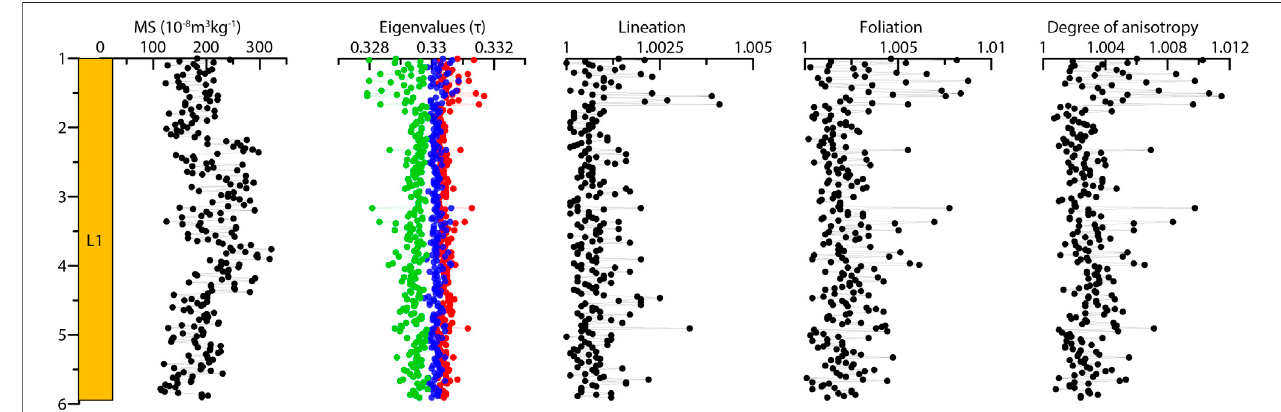
FIGURE 4 | The depth vs. variation of magnetic susceptibility, eigenvalues of three principal anisotropy of magnetic susceptibility axes ( τ max in red, τ int in blue, and τ min in green), lineation, foliation, and degree of anisotropy in the Lingyuan section.